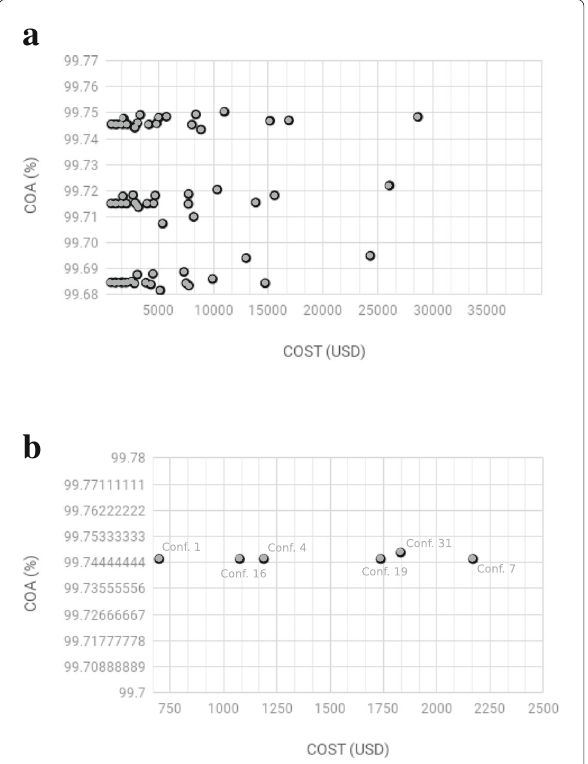
Fig. 9 Ranking of the configurations generated for the third case scenario. a Overview of all ranked configurations. b Optimal